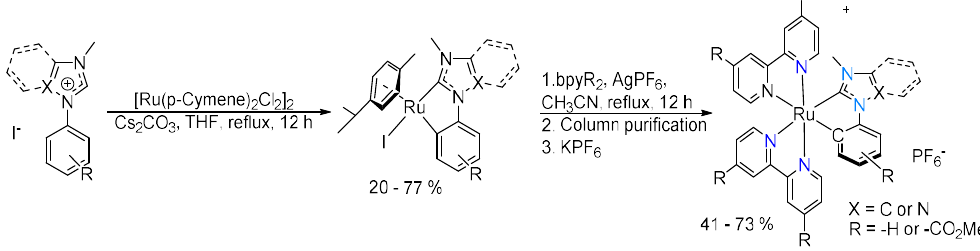
Scheme 5. Synthesis of new cyclometalated ruthenium complexes with N -heteroleptic carbene